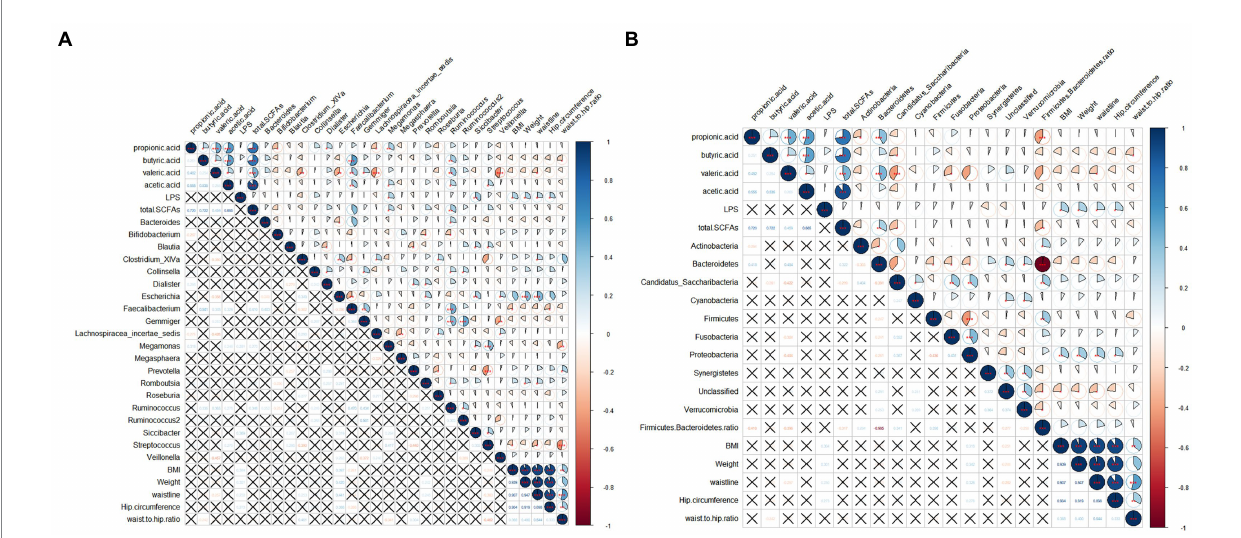
FIGURE 9 Correlation analysis among obesity indicators, gut microbes, SCFAs, and LPS. (A) Correlation between abundances of dominant bacterial genera and other indicators; (B) Correlations between abundances of gut microbes at the phylum level and other indicators. The pie chart on the upper right indicates the magnitude of the correlation, with a star indicating significance; the bottom left indicates the correlation coefficient. A cross indicates that the correlation is not significant. Spearman was used to test for